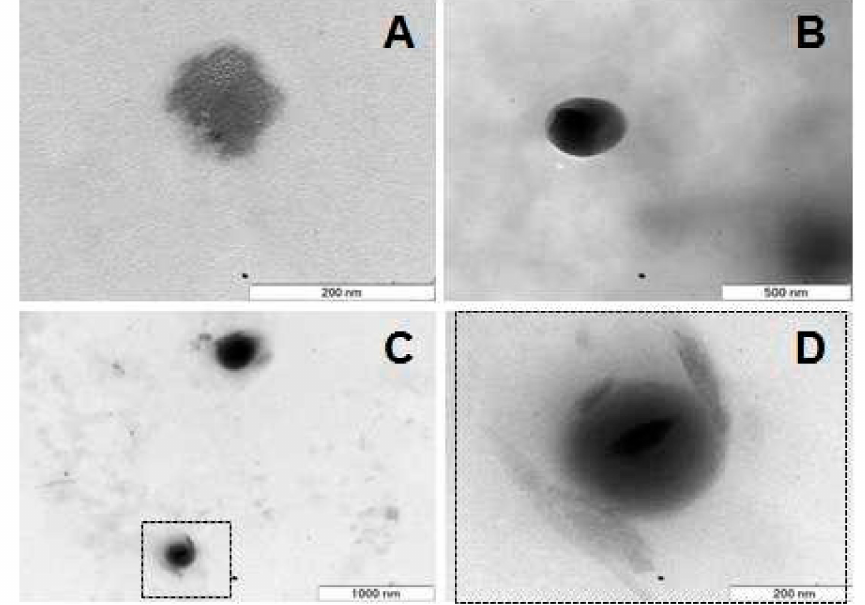
Figure 5. Micrographs obtained by TEM, where solid particulate material is evident: an empty SLN ( A ), an etofenamate-SLN ( B ), and an ibuprofen-SLN ( C , D ). Image ( D ) corresponds to a zoom of the dashed outlined rectangle from image ( C ). Scale bars: 200 nm ( A , D ), 500 nm ( B ), and 1000 nm ( C